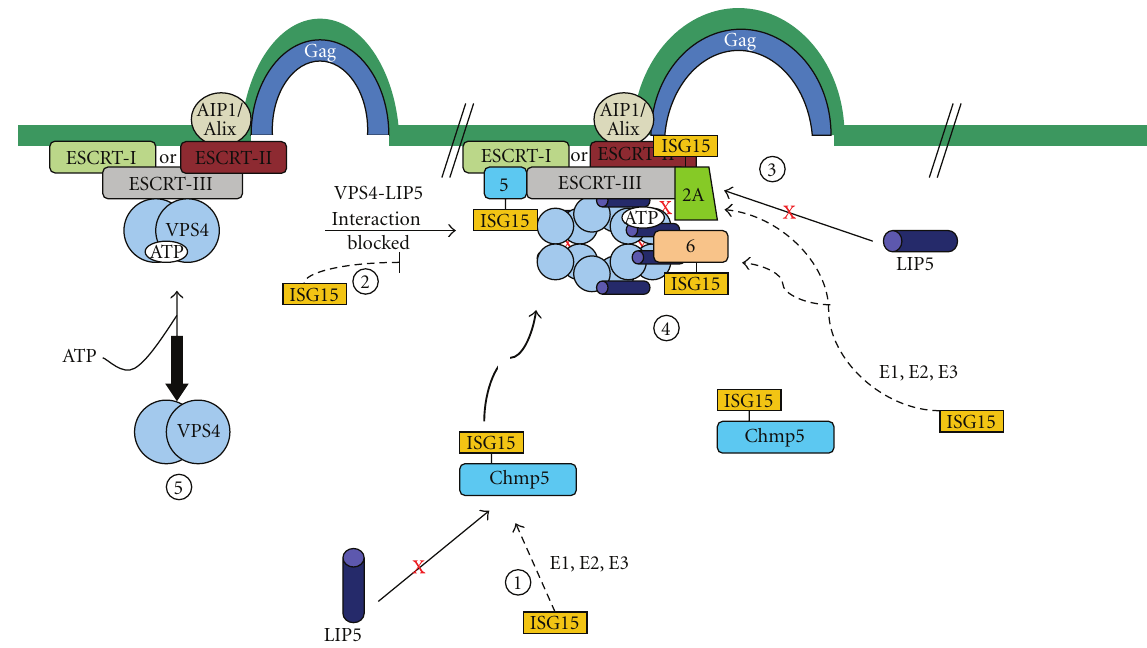
Figure 2: The mechanism of inhibition of budding late in the process mediated by ISG15 expression in cells. Step 1: The ESCRT-III protein, CHMP5, binds to LIP5 in the cytosol. In the presence of ISG15-specific E1, E2, and E3 ISG15 ligase complex, ISG15 is conjugated to CHMP5 and the binding to LIP5 is lost. Step 2: The CHMP5-ISG15 conjugate accumulates in the budding complex on the membrane. The interaction between VPS4 and its coactivator LIP5 is blocked preventing activation of the ATPase through formation of the VPS4/LIP5 double hexamer structure. Step 3: CHMP2A is ISGylated in the presence of ISG15-CHMP5. This results in the loss of its binding to LIP5 and weakens its direct interaction to VPS4. Step 4: CHMP6 is ISGylated in the presence of ISG15-CHMP5. This results in weakening of its binding to